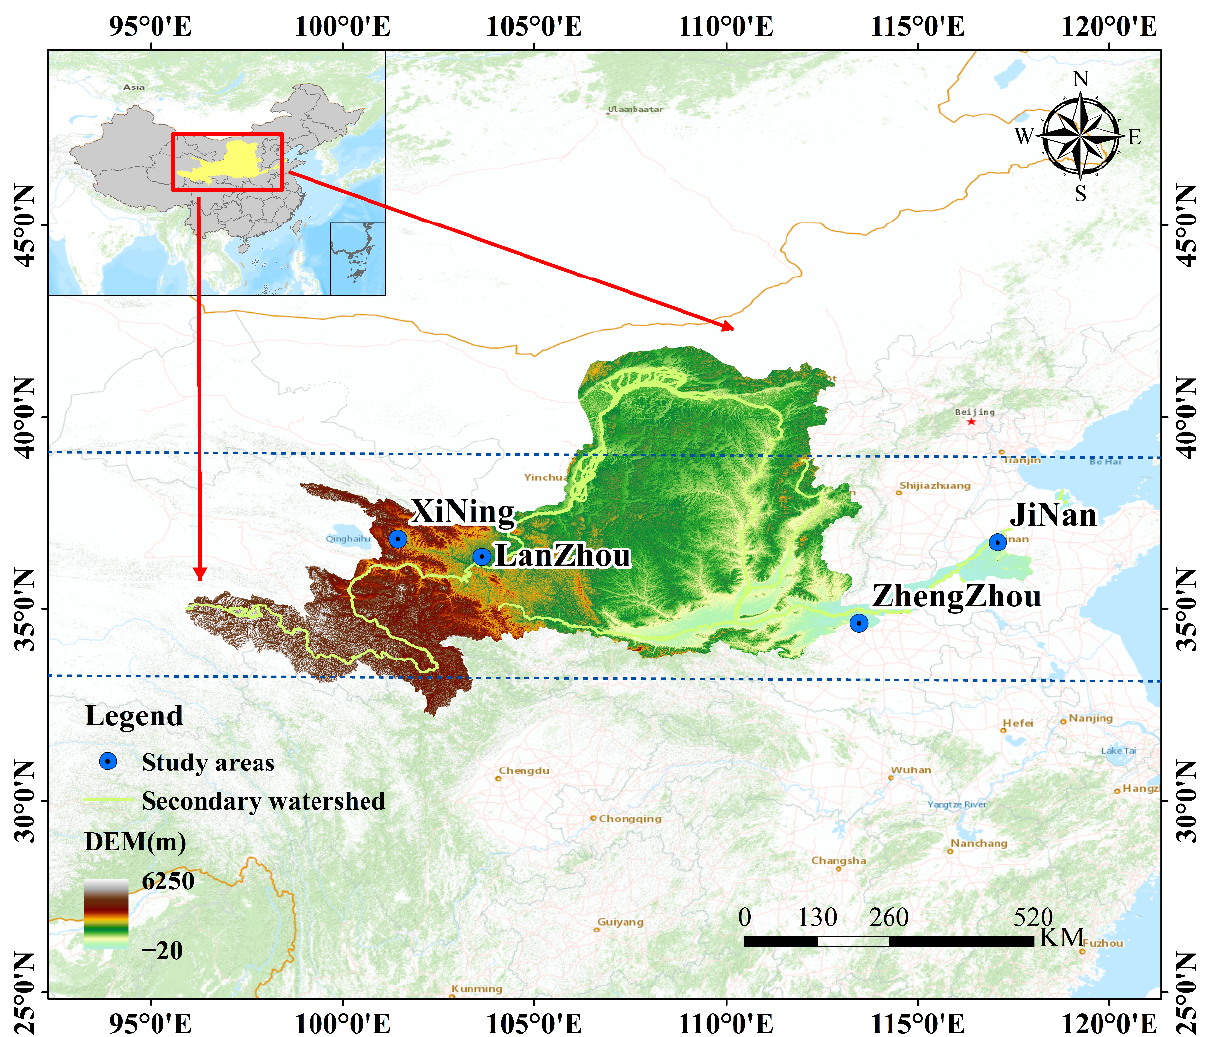
Figure 1. The location of four cities (Xining, Lanzhou, Zhengzhou and Jinan) in the Yellow River Basin.